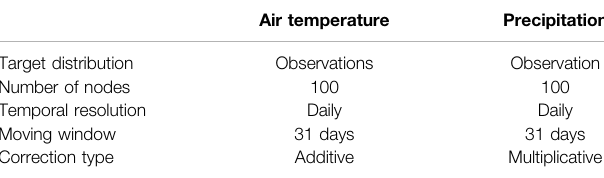
Figure 1B schematizes an asynchronous con fi guration of the hydroclimatic modeling chain. Instead of